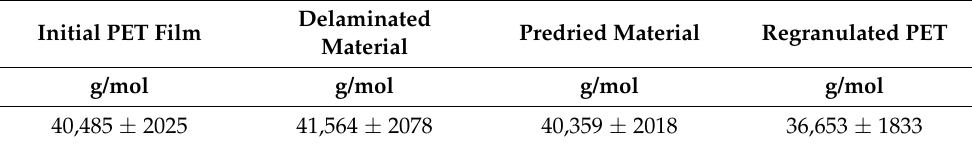
Table 6. Influence of the individual recycling steps on the molecular weight of